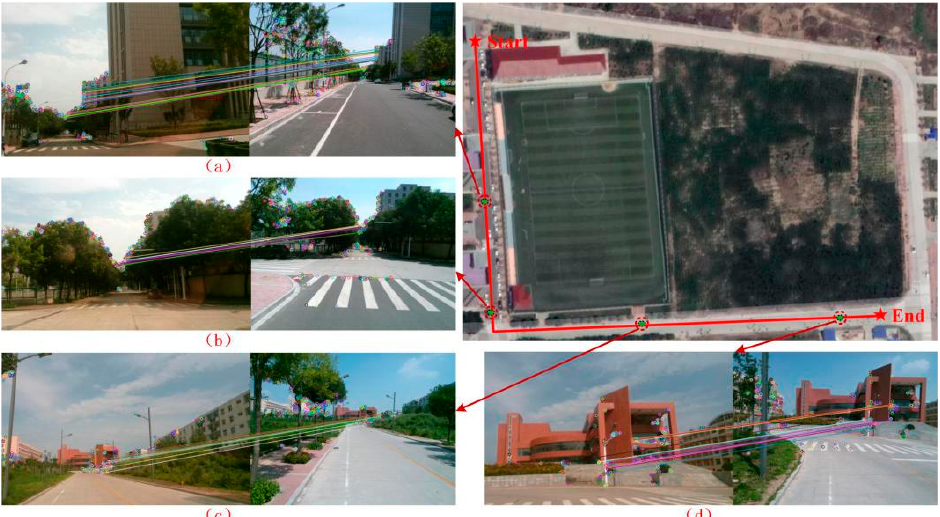
Figure 7. Experiment place and trajectory. ( a ) The first experiment; ( b ) The second experiment.